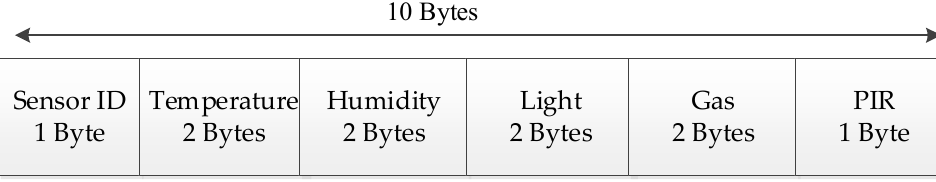
Figure 7. The payload of the uplink message.